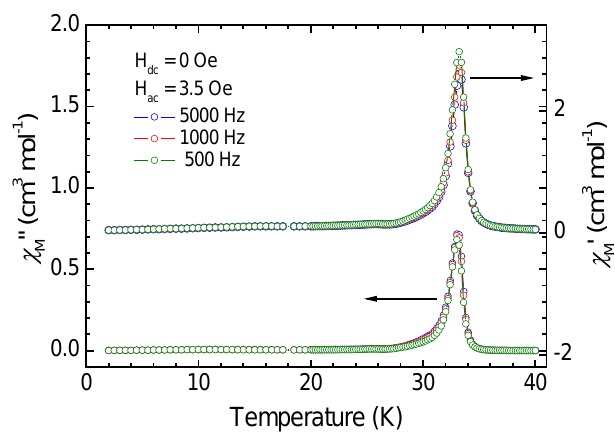
Figure 6. In- phase (χ′) and out -of- phase (χ′′) of the ac magnetic susceptibilities in a zero applied dc field and a 3.5-G ac field at the indicated frequencies for Compound 1 .